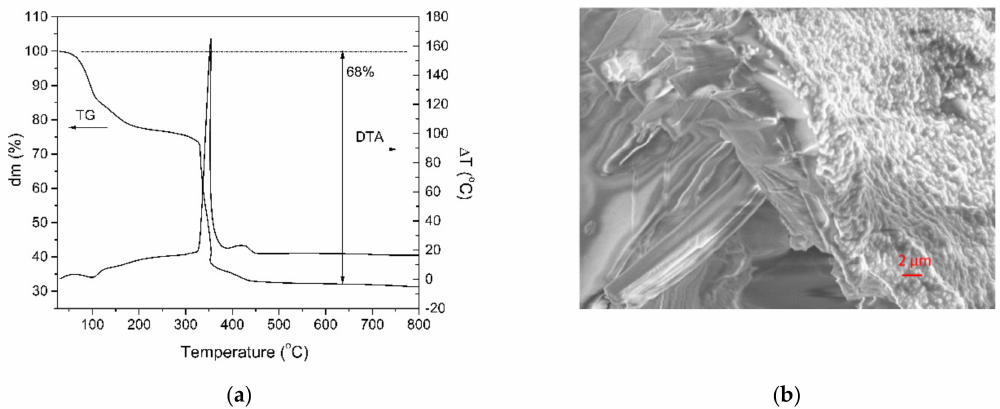
Figure 1. ( a ) TG-DTA analyses of the single crystal complex performed in air and ( b ) the SEM image of the quasi-cleavage fracture of the [{La 2 Mn 3 (EDTA) 3 (H 2 O) 11 } · 12H 2 O] n crystal at a magnification of 710 × . The [{La 2 Mn 3 (EDTA) 3 (H 2 O) 11 } · 12H 2 O] n crystal microstructure was investigated by scanning